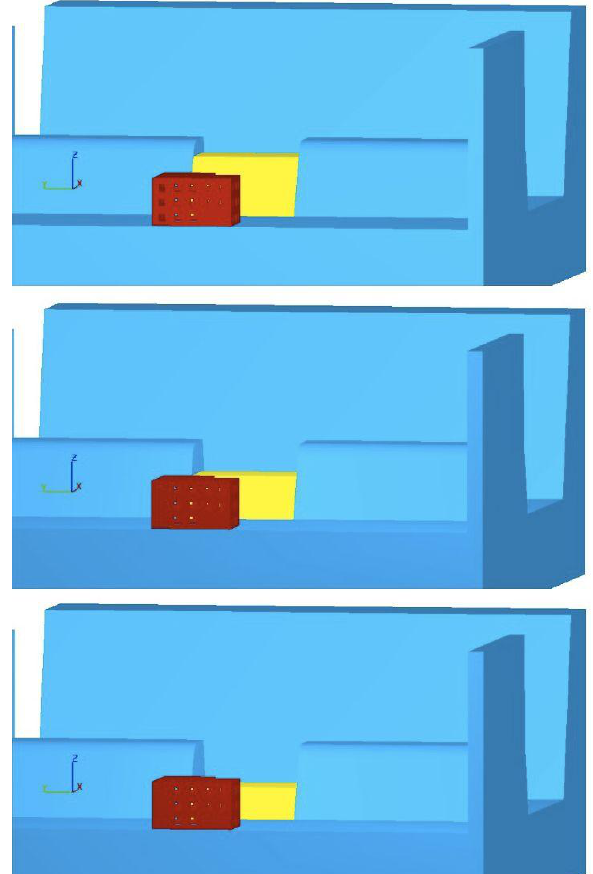
Figure 5. Geometry representation of the model. Yellow colour represents the river bank which breaks at 3 m, 6 m and 8 m respectively from top to bottom. The red cube is the building and the blue is the overall geometric